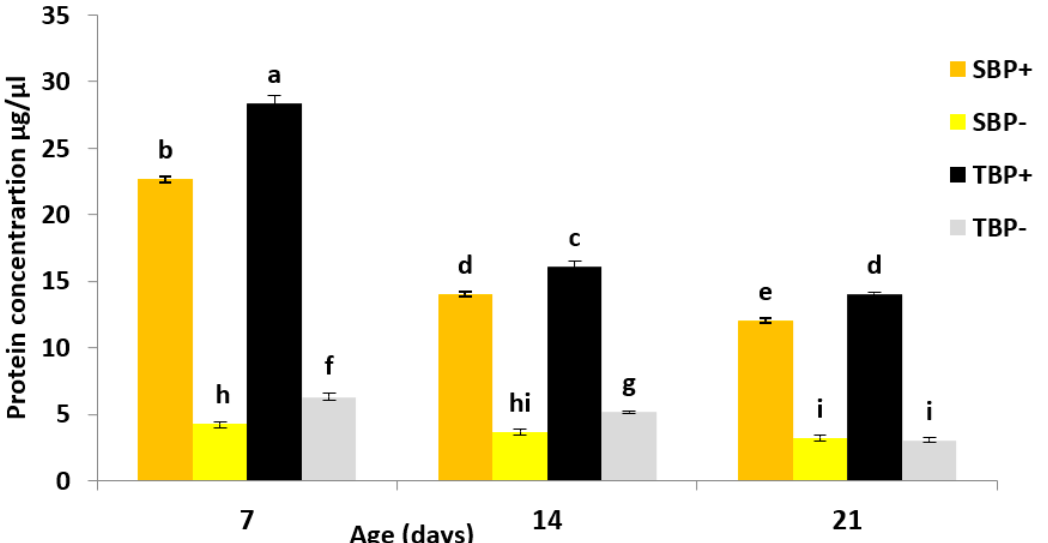
Figure 1. Mean ± SE protein concentration in hemolymph of both the subspecies of bees at 7, 14 and 21 days. SBP+: A. mellifera sahariensis with pollen, SBP − : A. mellifera sahariensis pollen-deprived, TBP+: A. mellifera intermissa with pollen, TBP − : A. mellifera intermissa pollen-deprived. The error bars represent the standard deviation from the respective means. Bars with the same letter are not significantly different ( p < 0.05).